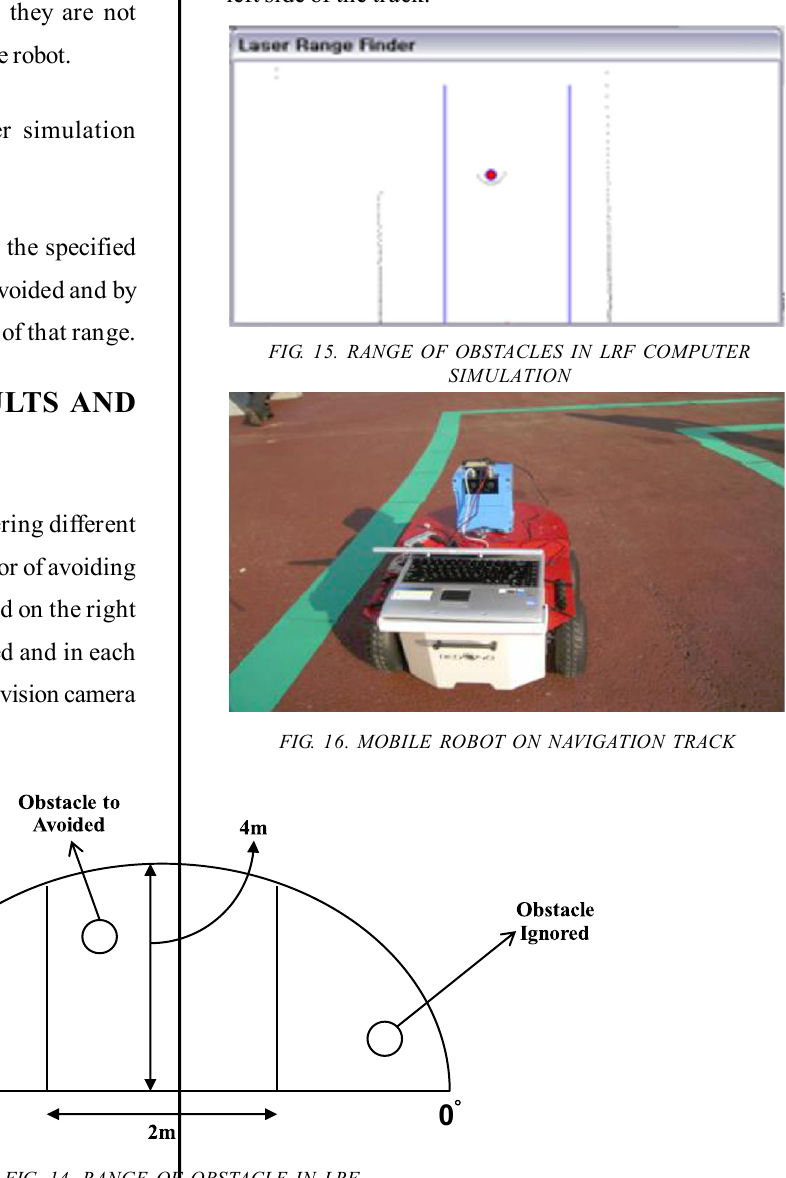
FIG. 14. RANGE OF OBSTACLE IN LRF